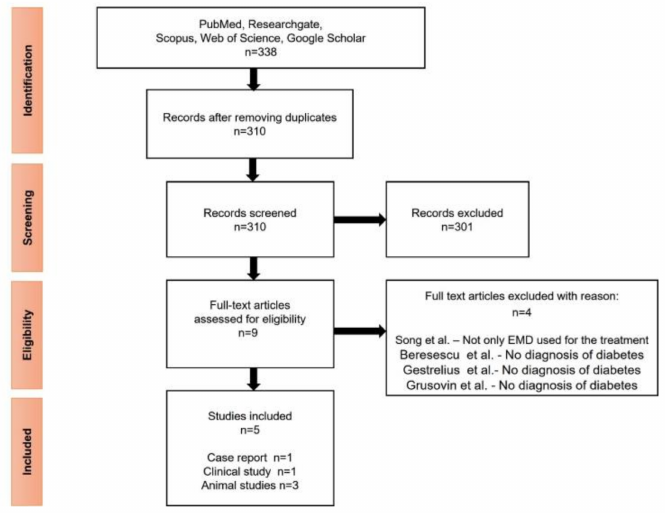
Figure 1. Flow chart of methodology according to